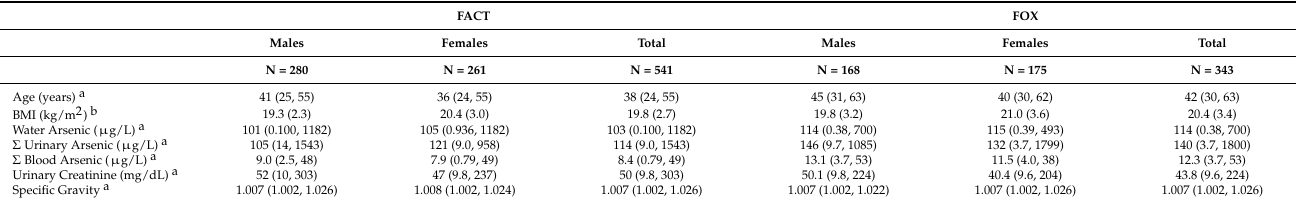
Table 1. Participant Characteristics in FACT and FOX stratified by